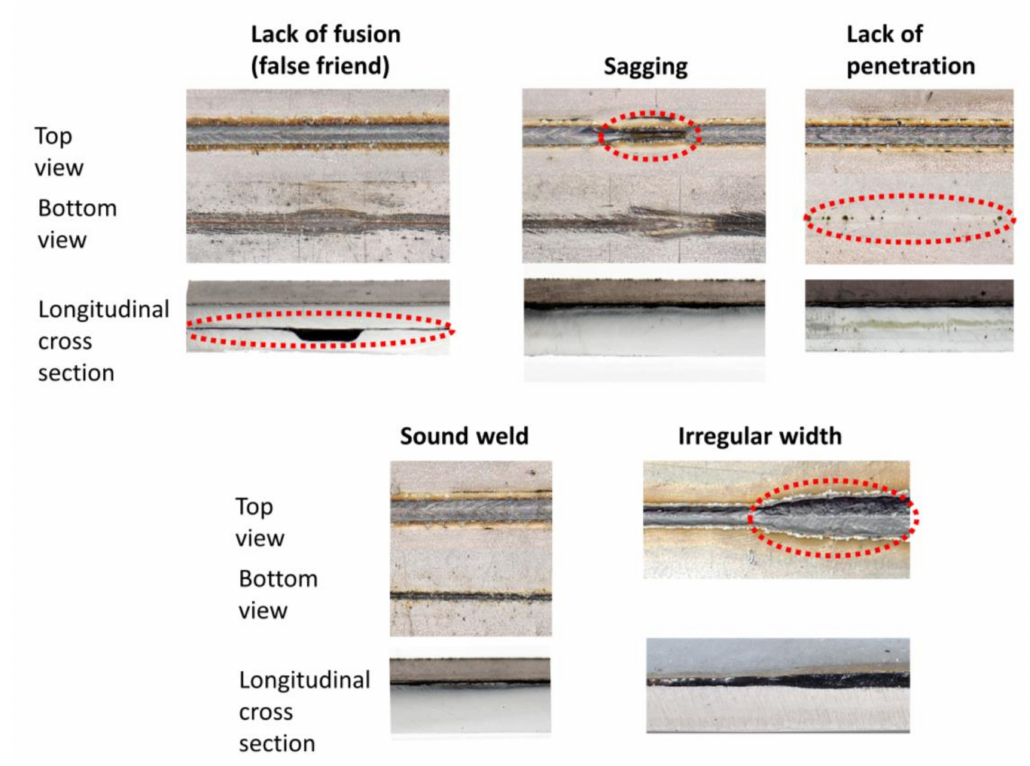
Figure 6. Photographs from different perspectives of the welding defects investigated in this